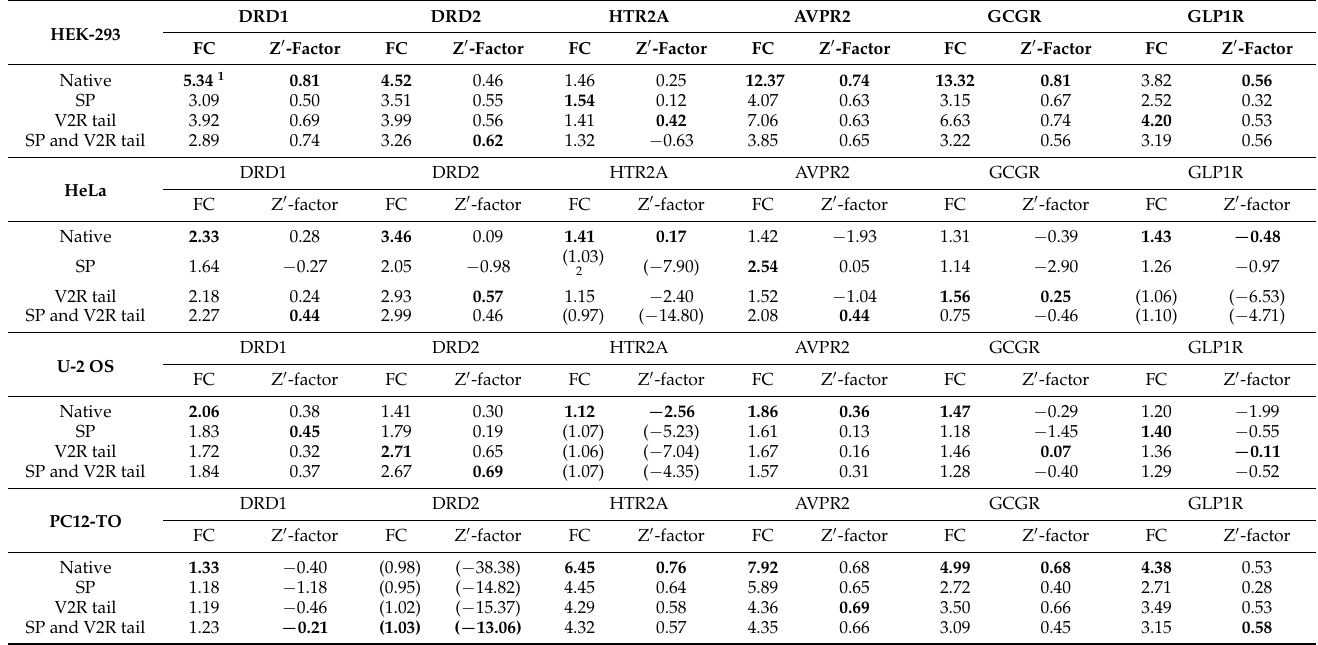
1 Numbers highlighted in bold indicate the highest fold-change and Z (cid:48) -factor values for each GPCR in each cell line; i.e., considering the four variants of each GPCR used (native form, SP-GPCR variant, GPCR-V2R variant, and SP-GPCR-V2R variant). Results were calculated from experiments with 6 replicates. 2 Numbers in parentheses indicate that the p -value was larger than 0.05 as calculated via the two-sided Student’s t